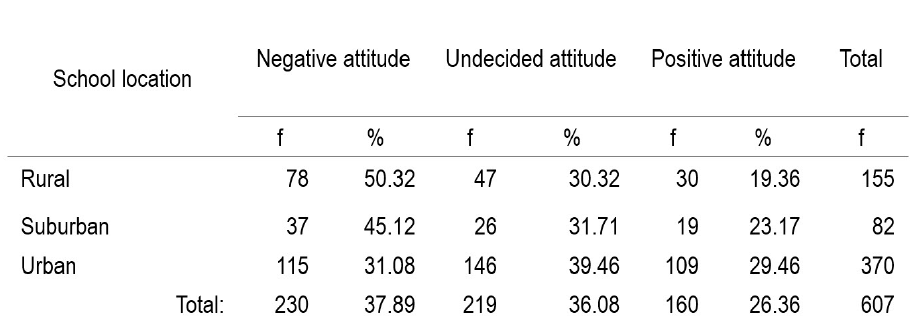
Teachers’ views on the material and technical conditions of students for active participation